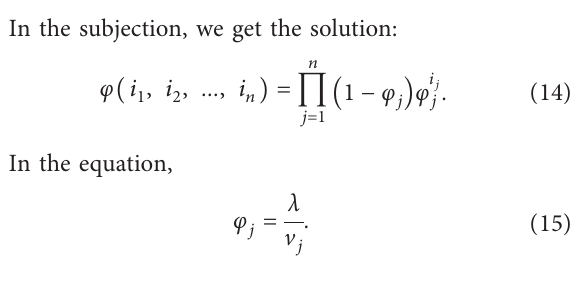
Figure 4: Queue model of the boarding